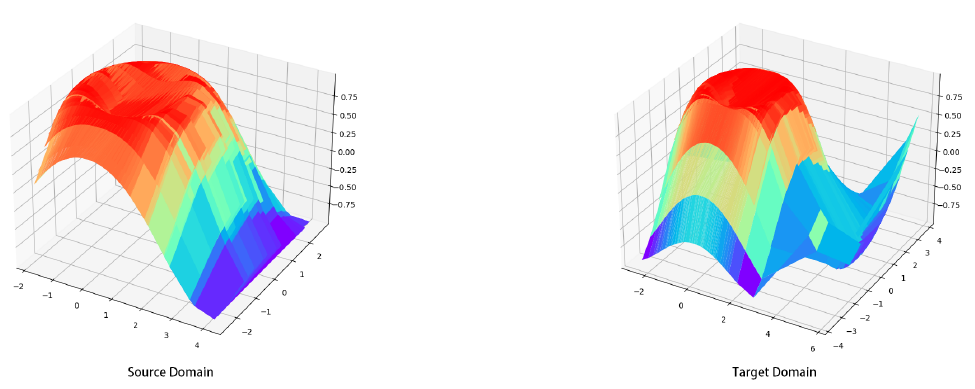
Figure 3. Visualization results of features of the source domain and target domain in three- dimensional